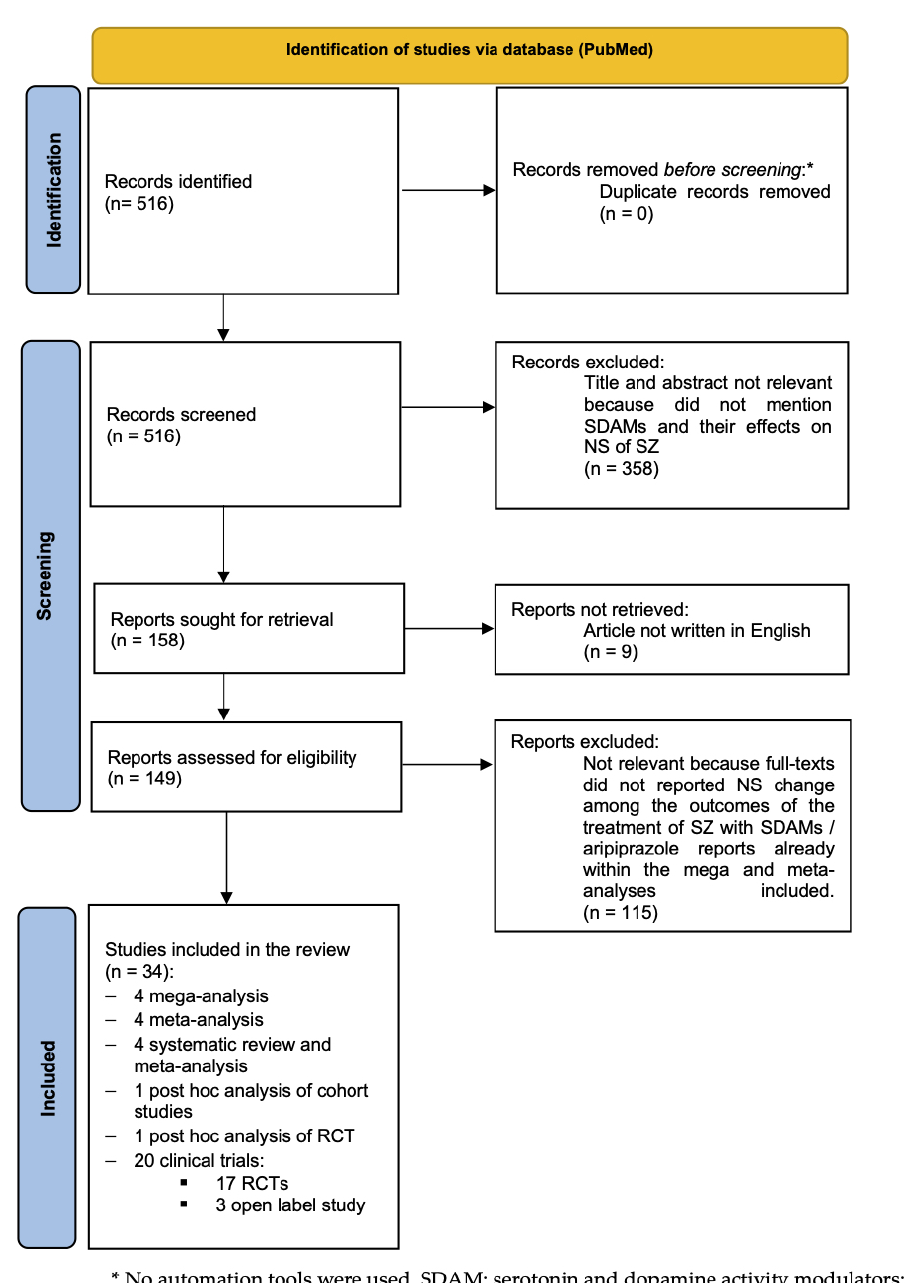
Figure 1. Selection flow-chart.